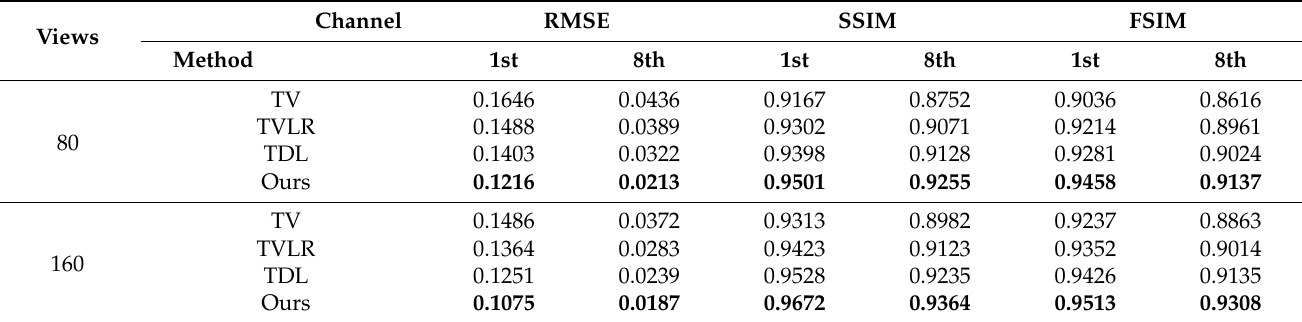
Table 1. Comparison of indicators in different angles using different